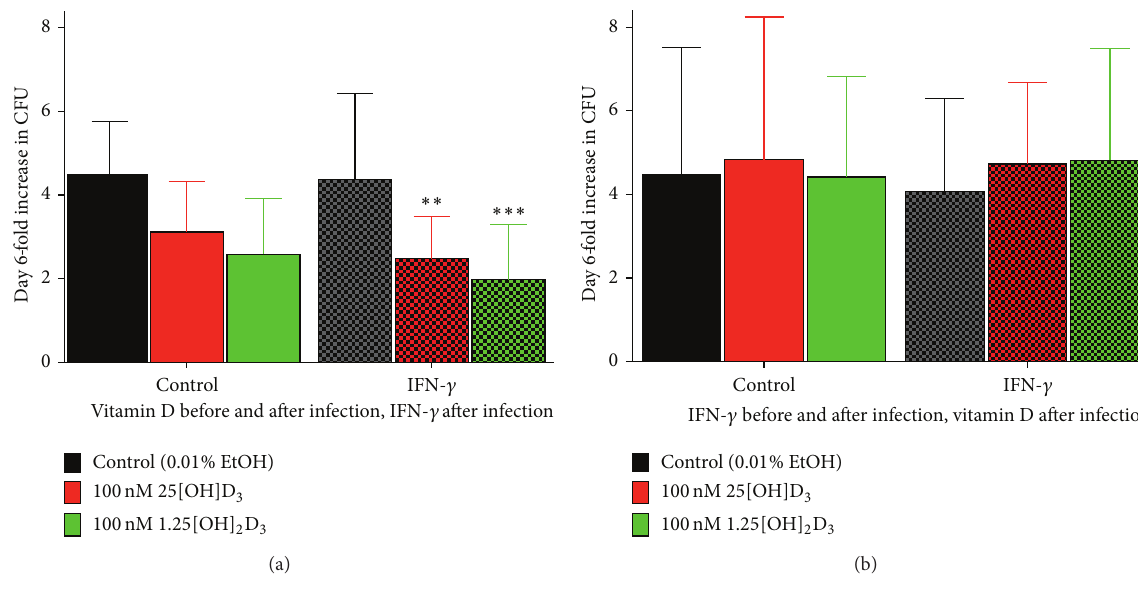
Figure 4: Interferon-gamma (IFN- 𝛾 ) enhances the antimicrobial action of monocyte-derived macrophages (MDM) infected with Mycobacterium tuberculosis only in vitamin D sufficient conditions. (a) MDM differentiated in the presence of vitamin D significantly inhibits MTBgrowth in responseto postinfection IFN- 𝛾 (200IU/mL) treatment. This scenario represents thelogical physiological process of infection response under vitamin D sufficient conditions. (b) However, pretreatment of MDM with IFN- 𝛾 (200 IU/mL) for 48 hr before infection and during infection in vitamin D deficient conditions does not enhance the response to vitamin D treatment after infection. Mean ± SD, 𝑛 = three donors, each in